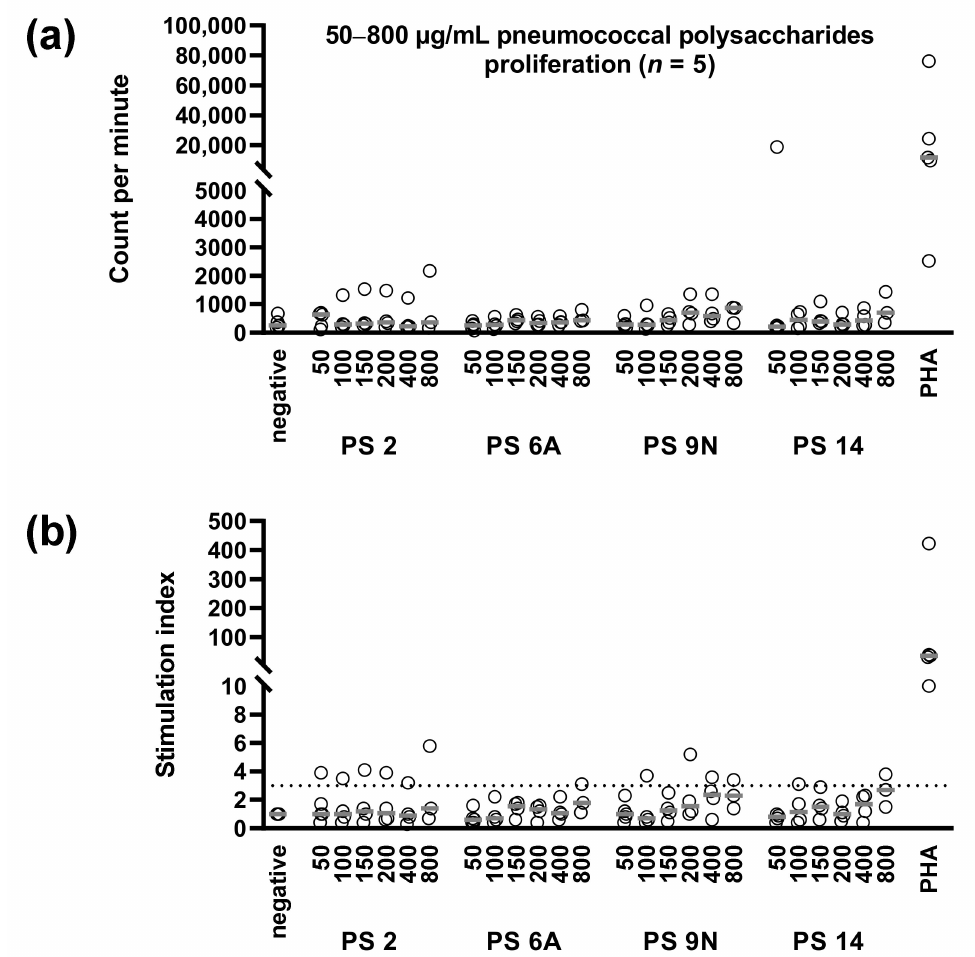
Figure 4. Proliferative responses in vaccinated kidney transplant recipients after stimulation with polysaccharides from S. pneumoniae . ( a ) Results given as counts per minute increment; ( b ) stimu- lation index, i.e., as a quotient of stimulated and unstimulated cultures. We used pneumococcal polysaccharides of serotype (PS) 2, 6A, 9N, and 14 at concentrations of 50–800 µ g/mL and cul- tured cells for six days. Stimulation indices of at least 3 were defined as positive response (dotted line). Median values are indicated by grey horizontal lines. Negative controls were cells cultured without specific stimulation, and positive controls cells were stimulated with the T-cell mitogen phytohemagglutinin